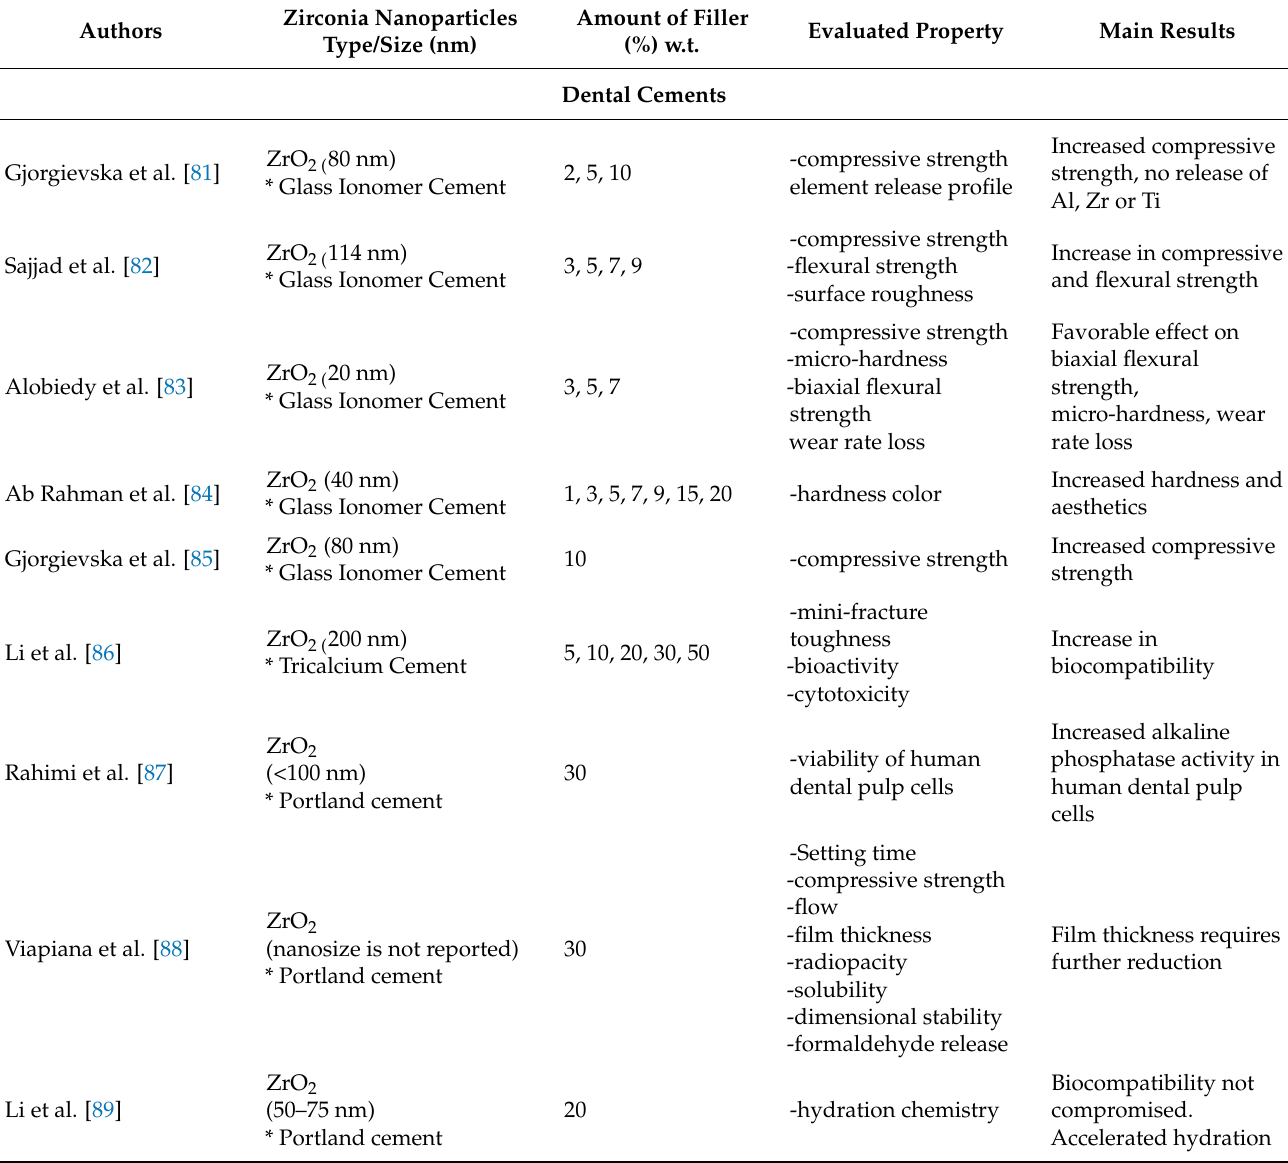
Table 4. Studies involving zirconia nanoparticles in dental cement, composites and